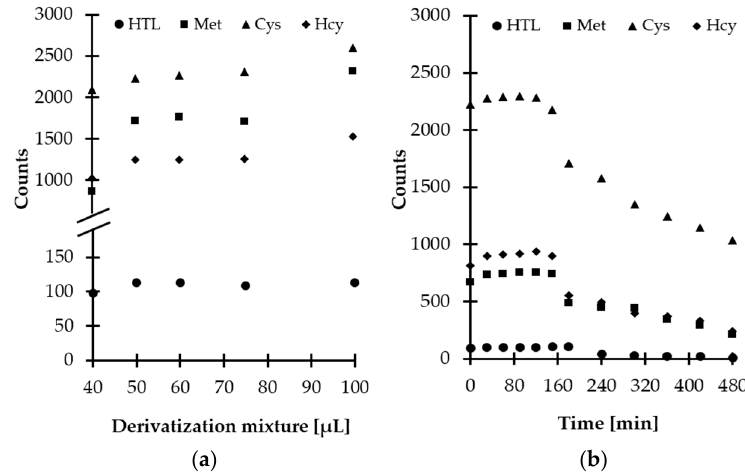
Figure 5. Derivatization reaction yield as a function of ( a ) reagent excess, ( b ) time combined with examination of HTL/Met/Cys/Hcy-TMS derivatives stability in autosampler, expressed as a peak height of HTL/Met/Cys/Hcy-TMS derivatives. Samples were analyzed according to the procedure described in Section 3.6.